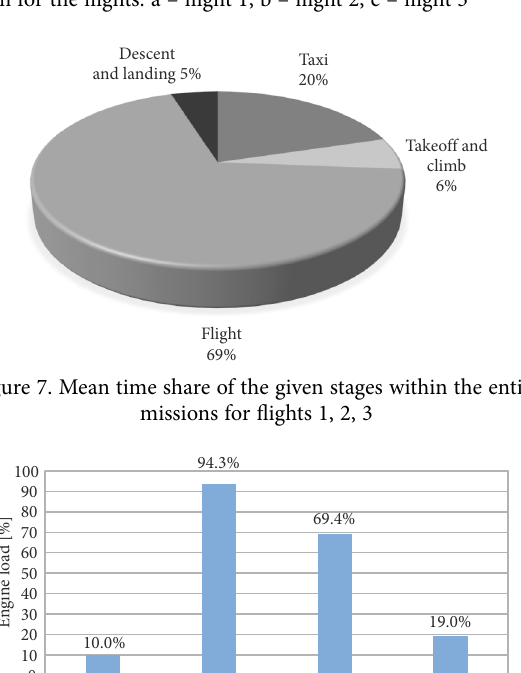
Figure 6. Time share of the given stages within the entire mission for the flights: a – flight 1; b – flight 2; c – flight